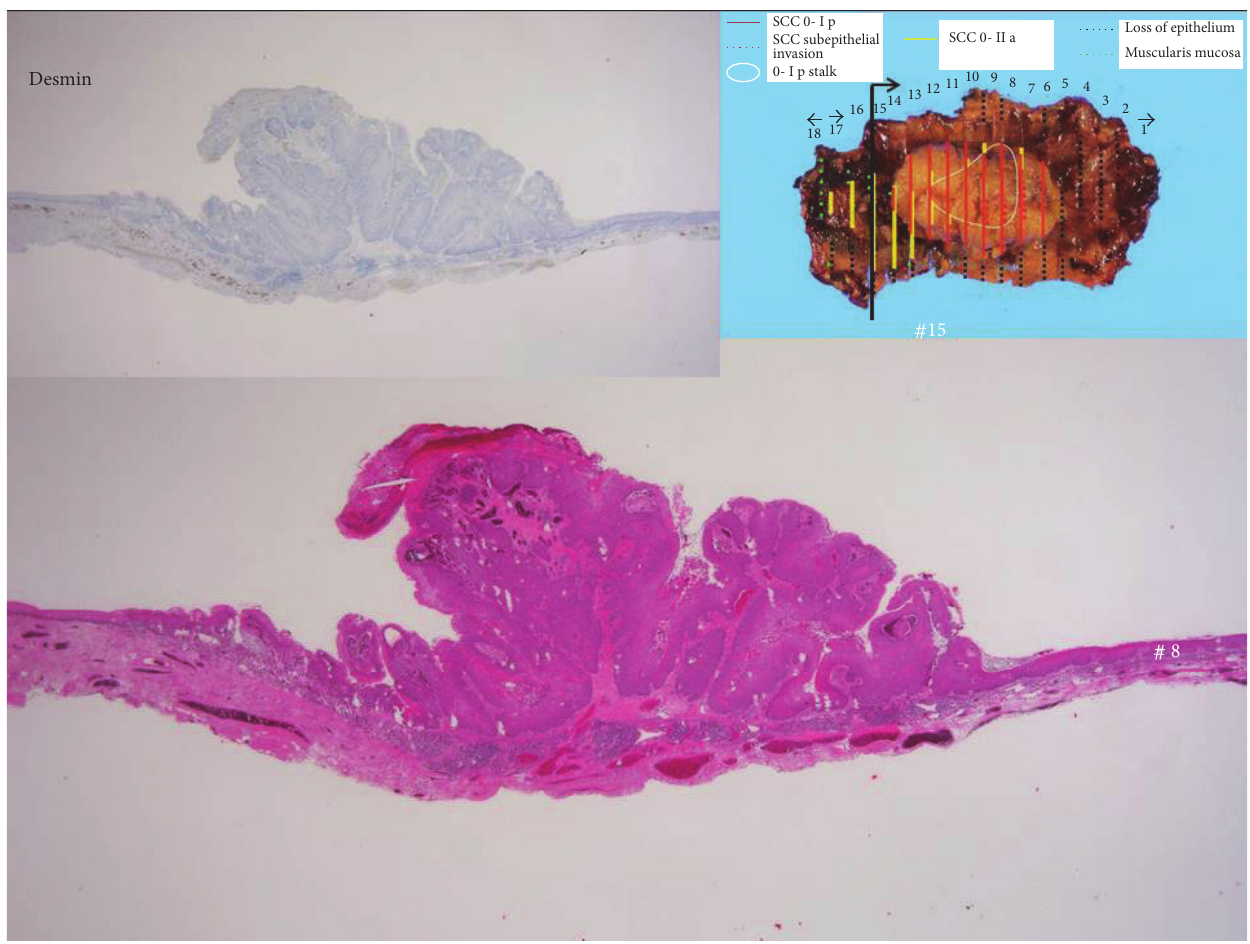
Figure 6: At the anal side of the specimen, the muscularis mucosa was examined, and the tumor was confirmed to have spread to the cervical esophagus.